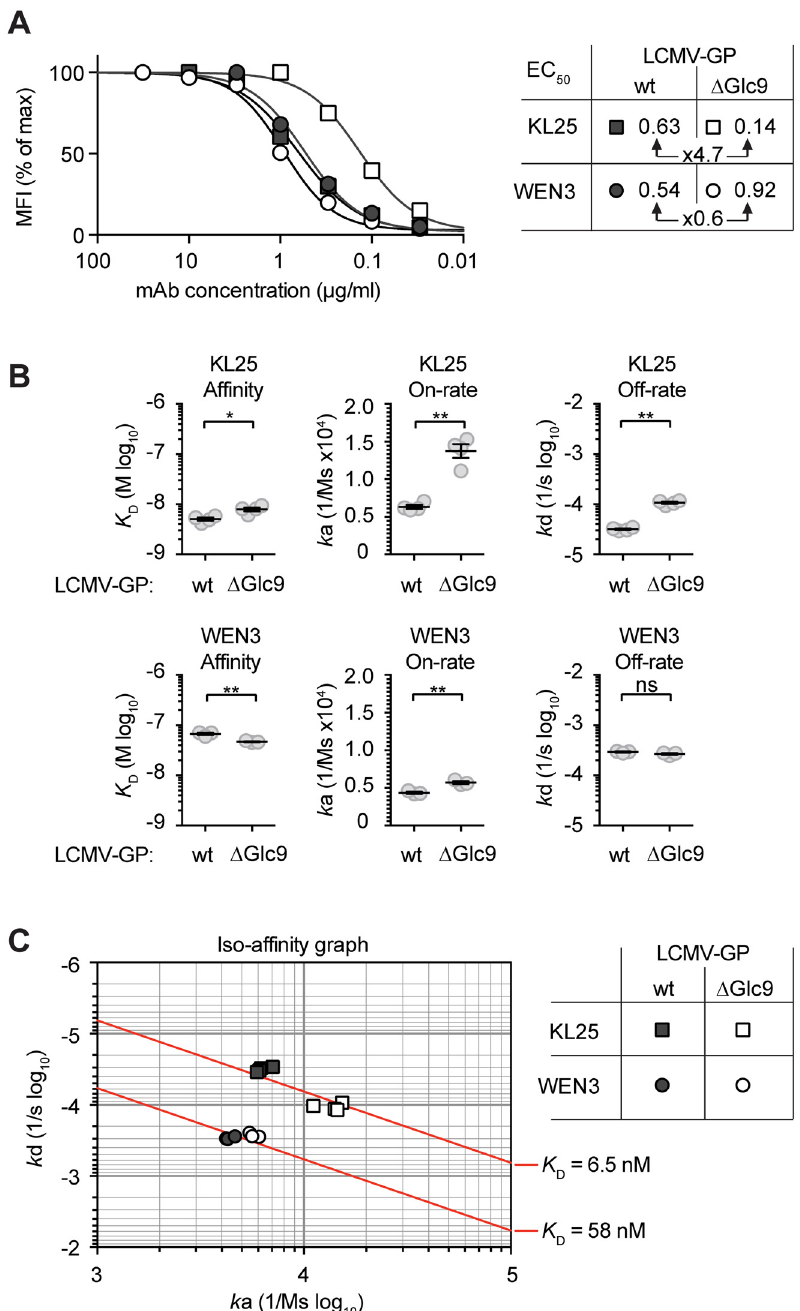
Fig 5. Facilitated binding of neutralizing mAb to Glc9-deficient LCMV-GP-1. (A) We transfected 293T cells with plasmids for expression of either LCMV-GPwt or LCMV-GP Δ Glc9. We then incubated these cells with titrated concentrations of KL25 or WEN3 mAbs, and saturation of LCMV-GP binding was characterized by flow cytometry. The mean fluorescence intensity (MFI) is plotted as percentage of maximum staining intensity. Untransfected cells were used for reference. The 50% effective concentrations (EC 50 ) are displayed in the chart. One out of two representative experiments is shown. (B-C) Binding kinetics of KL25 and WEN3 Fab fragments to LCMV-GPwt or LCMV-GP Δ Glc9 were characterized by surface plasmon resonance (SPR). The association constant ( k a), dissociation constant ( k d) and the resulting equilibrium dissociation constant ( K D = k d/ k a) were determined. Each measurement was done in triplicates for WEN3 and quadruplicates for KL25, respectively. In panel (B) means ± SEM are indicated. * p < 0.05, ** p < 0.01 by unpaired student ’ s